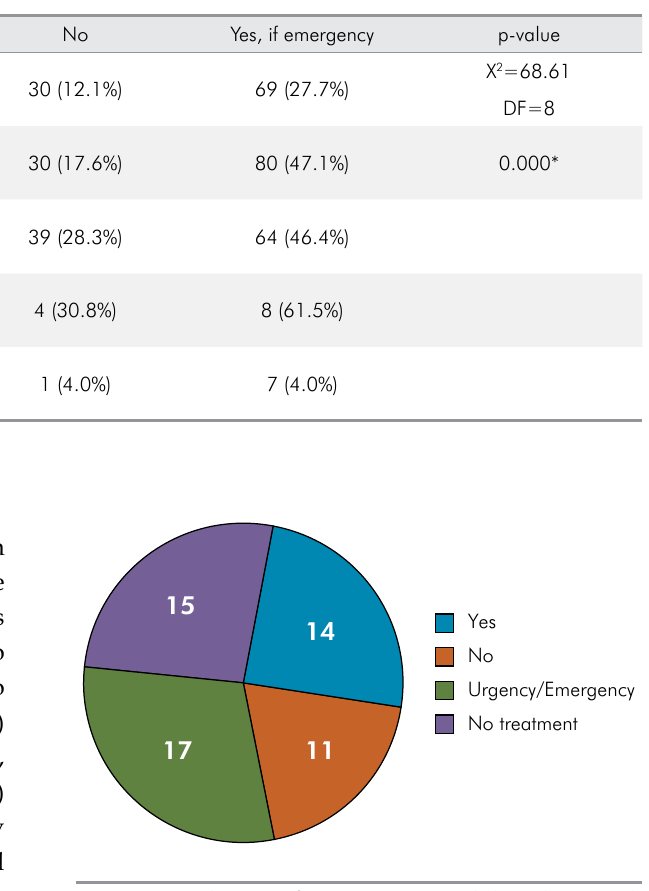
Figure 6. Risk group for COVID-19 and the relation with receiving dental treatment at the moment.